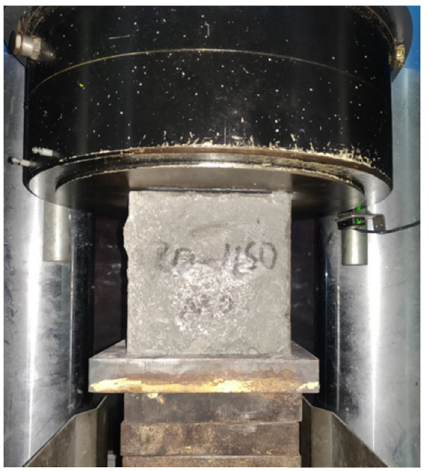
Figure 3: Photograph of the cubic compression test.